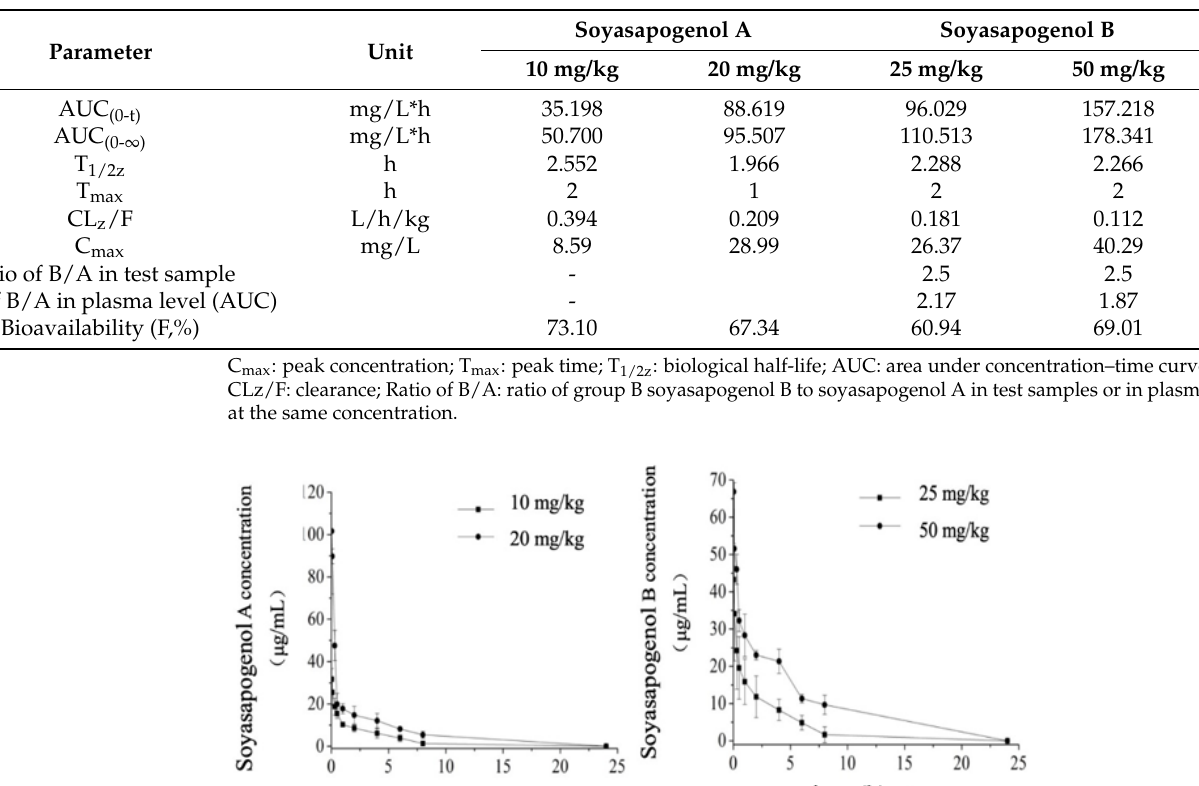
Table 1. Summary of pharmacokinetic parameter values (mean, n = 6) for soyasapogenols A and B after oral (P.O.) dose administration.